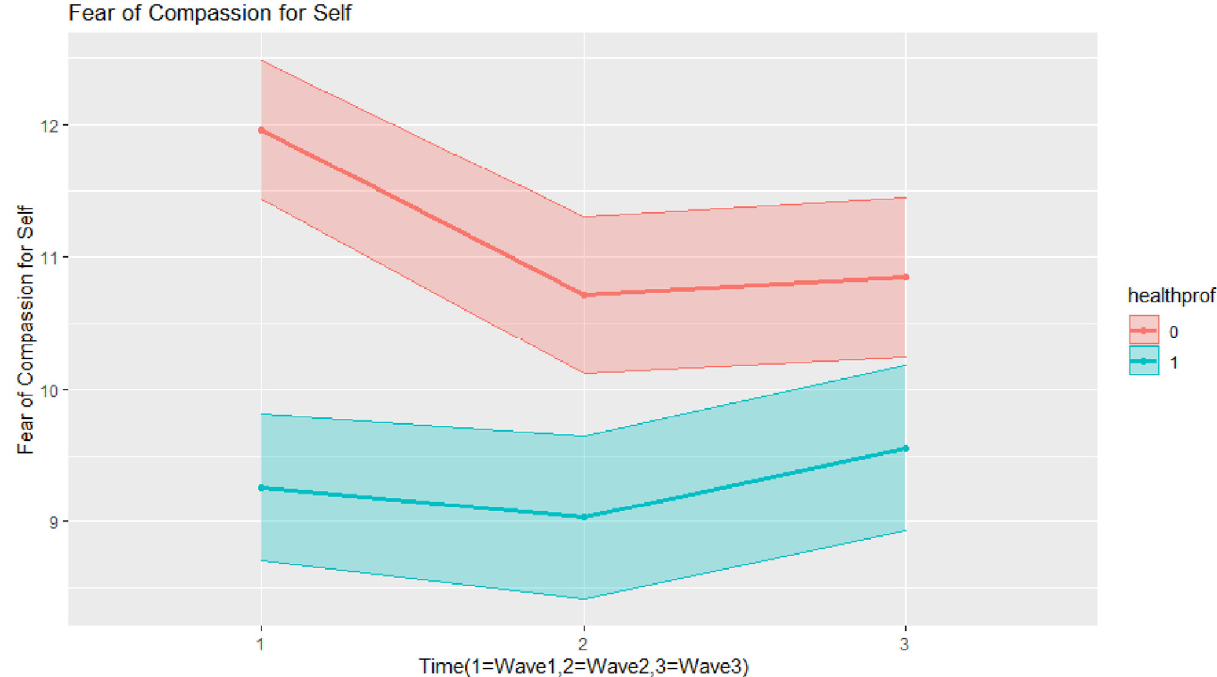
Figure 1. Interaction effects in the final model for fears of self-compassion. Table 5. Estimates of the final model for fears of compassion for others. Fixed